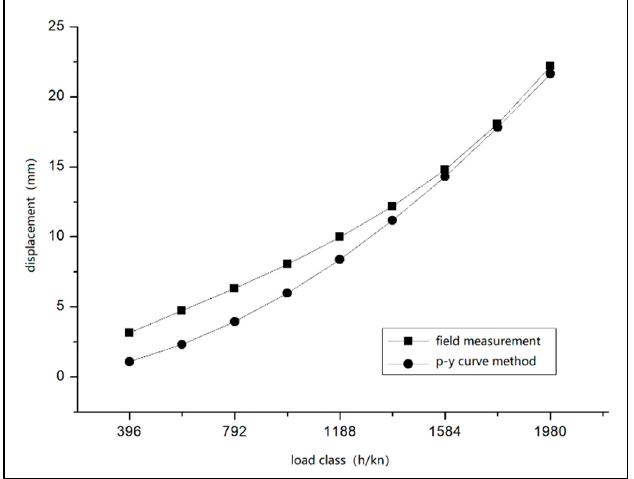
Figure 16. Comparison diagram of load–displacement curve of 2-8# test pile.